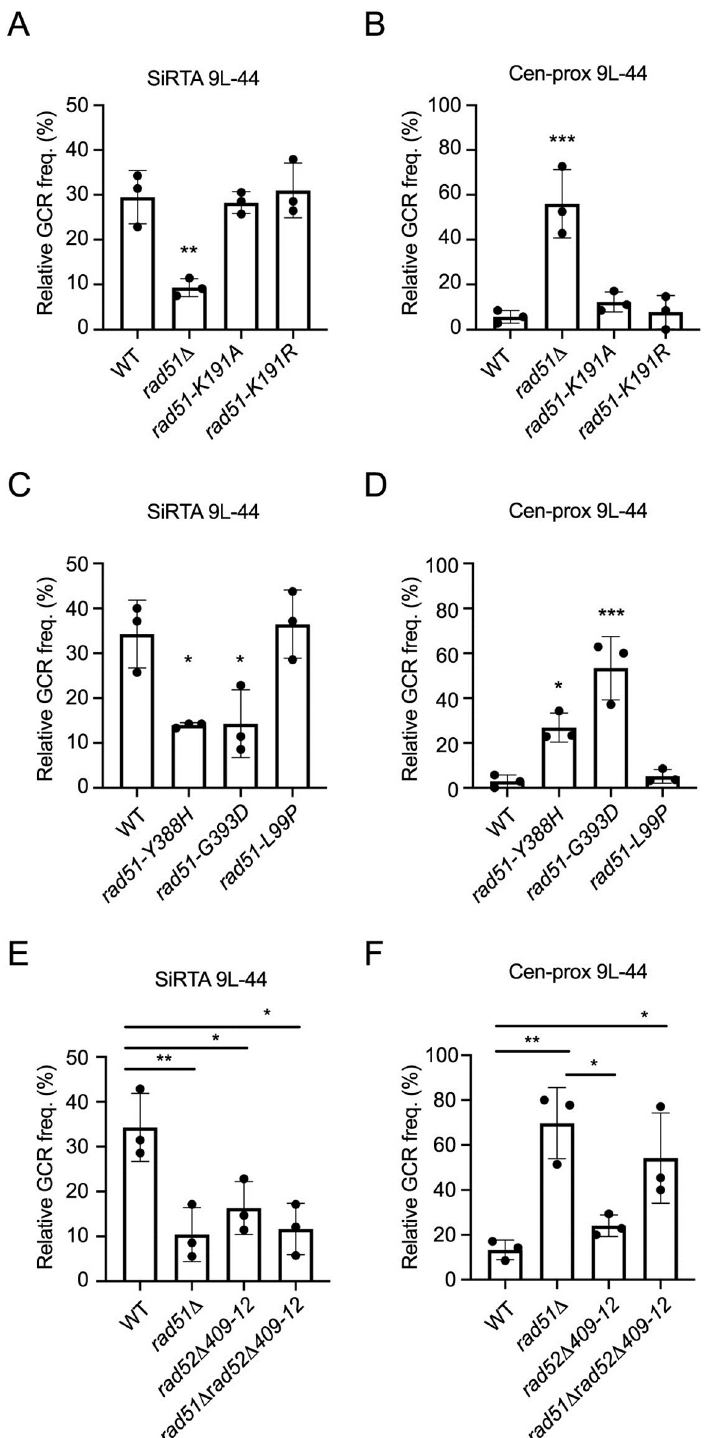
Fig 4. The Rad52-dependent effects of Rad51 on telomere addition and micro-homology mediated repair require the Rad51-Rad52 interaction. (A-D) The relative GCR frequency in SiRTA 9L-44 (A, C) or the centromere-proximal region (B, D) is shown for the indicated strains. Averages and standard deviations are from three independent experiments. Strains statistically different from the corresponding WT control strain by ANOVA with Dunnett’s multiple comparisons test are indicated by asterisks. (E-F) The relative GCR frequency in SiRTA 9L-44 (E) or